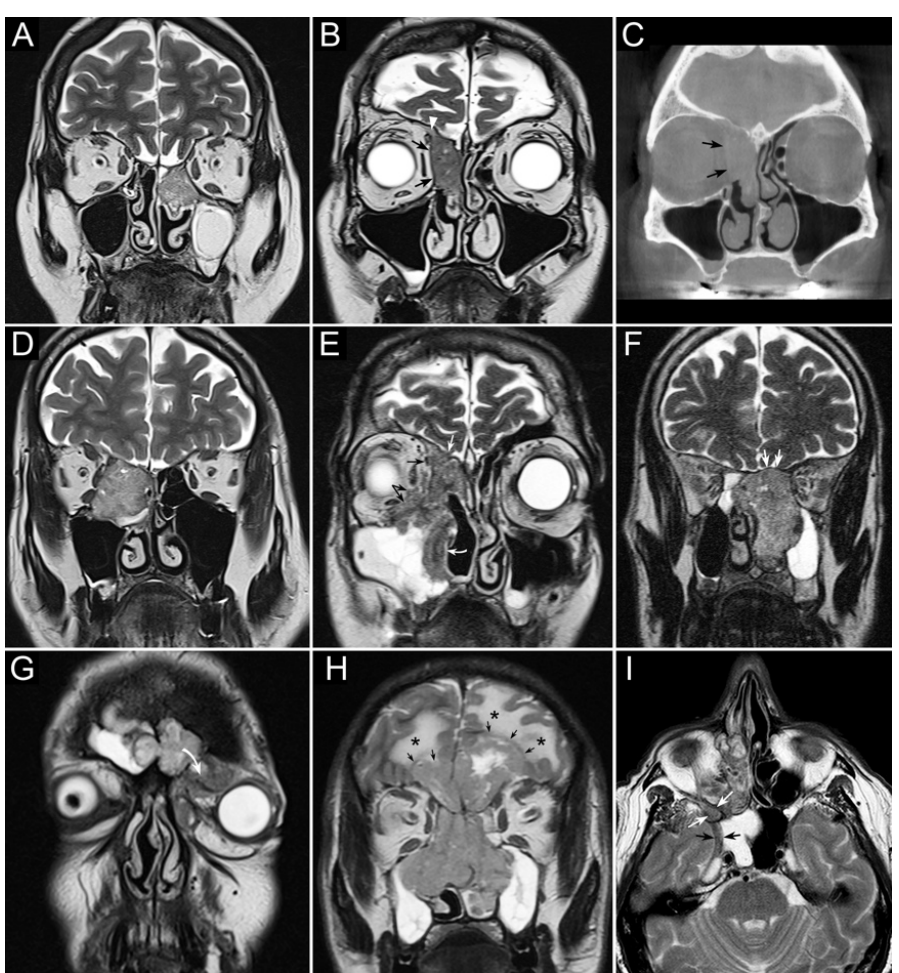
Figure 1. Panel summarizing several patterns of local extension of nasoethmoidal squamous cell carcinoma (SCC) and other epithelial cancers. ( A ) Left nasoethmoidal SCC with neuroendocrine features, limited to the nasoethmoidal compartment. ( B , C ) Non-keratinizing SCC of the right nasoethmoidal compartment determining resorption of the lamina papyracea (arrows in C ), with no frank transgression of the periorbit. A T2-hypointense line is visible between the tumor and extraconal fat (arrows in B ). The supraorbital ethmoidal recess is filled by dehydrated secretions (arrowhead in B ). ( D ) Orbit-encroaching right nasoethmoidal SMARCB1/INI1-deficient carcinoma. A T2-hypointense line separating the tumor from the extraconal fat cannot be clearly demonstrated. ( E ) Right nasoethmoidal poorly differentiated SCC invading the extraconal fat (black arrows), anterior skull base (white arrow), and medial maxillary wall (curved white arrow). ( F ) Left nasoethmoidal adenosquamous carcinoma determining cranial displacement of the T2-hypointense thin layer made up by the ethmoidal-sphenoidal roof and overlying dura mater (white arrows). ( G ) Left nasoethmoidal SMARCB1/INI1-deficient carcinoma involving both frontal sinuses and invading the orbital cavity through the floor of the left frontal sinus (curved arrow). ( H ) Non- intestinal-type adenocarcinoma of the nasoethmoidal box with massive transcranial extension (arrows). Brain edema (asterisks) suggests invasion of the cerebral parenchyma. ( I ) Poorly differentiated SCC of the right nasoethmoidal compartment, with involvement of the inferior orbital fissure (white arrows) and macroscopic perineural extension along a thickened maxillary nerve to reach the Meckel’s cave (black arrows).